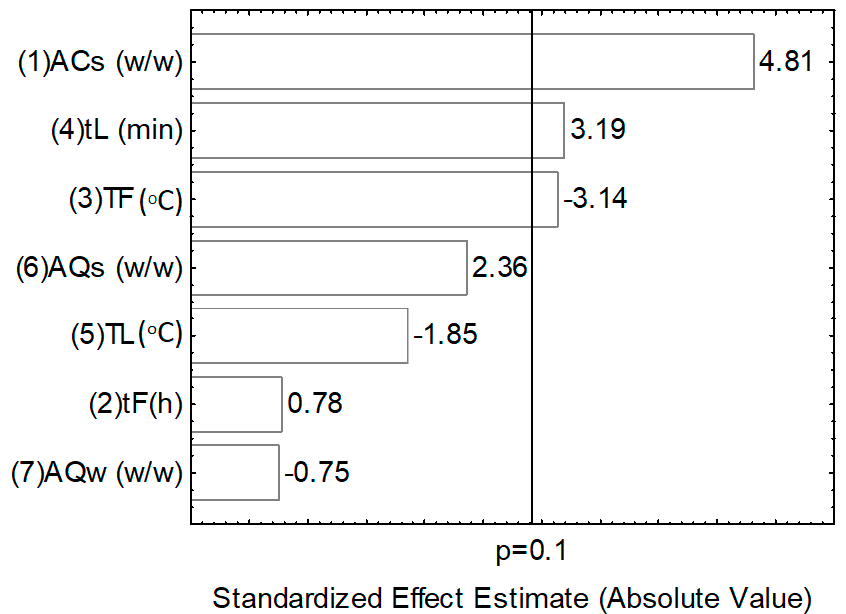
Figure 6. REE (RE) and iron (Fe) concentration (g/L)—screening experiments. Figures 7 and 8 show Pareto charts for REE extraction (%RE) and Fe extraction (%Fe).